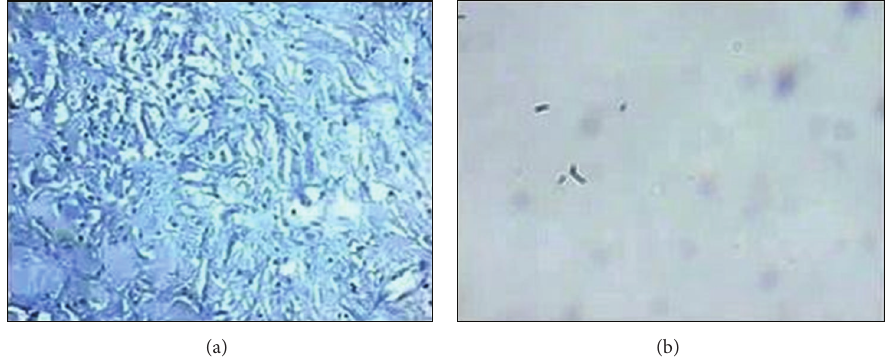
Figure 4: Microscopic pathologic examination showing reactive tissue with necroinflammatory infiltration, langerhans and giant cells, and calcified granuloma (a); Ziehl-Neelsen staining showing acid-fast bacilli